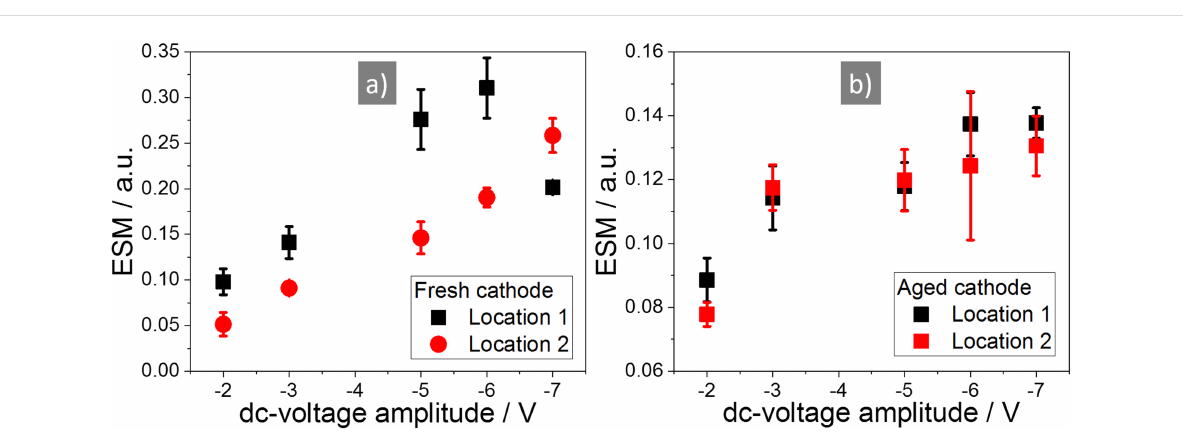
Figure 4: Evolution of the ESM signal intensity at the a) fresh cathode and b) aged cathode with the stepwise increasing dc-voltage pulse. The loca- tions for the fresh cathode are marked in Figure 3a in the bottom row. For the aged cathode see Supporting Information File 1, Figure